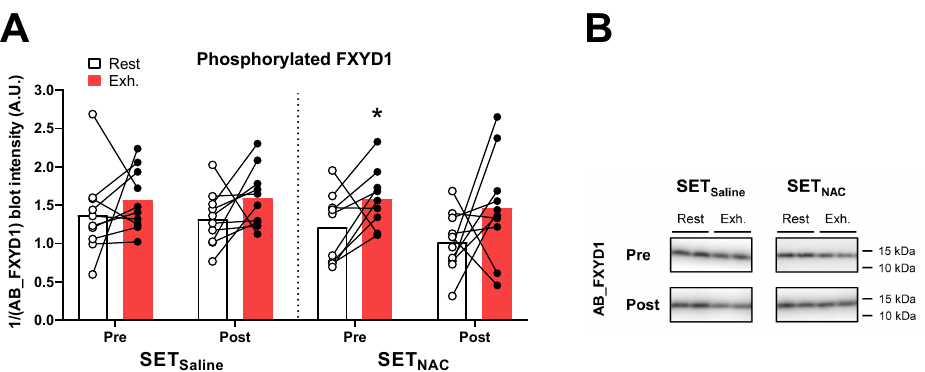
Figure 11. Effect of speed endurance training (SET) on the muscle content of ion-handling proteins and antioxidant enzymes. Phosphorylated FXYD1 ( A ) and representative blots ( B ) at rest and after knee-extensor exercise to exhaustion (exh.) without (SET Saline , n = 10) and with N -acetylcysteine (SET NAC , pre n = 9, post n = 10) infusion before (pre) and after (post) SET. * Exh. different from rest ( p < 0.05). Data are presented as mean with individual changes.